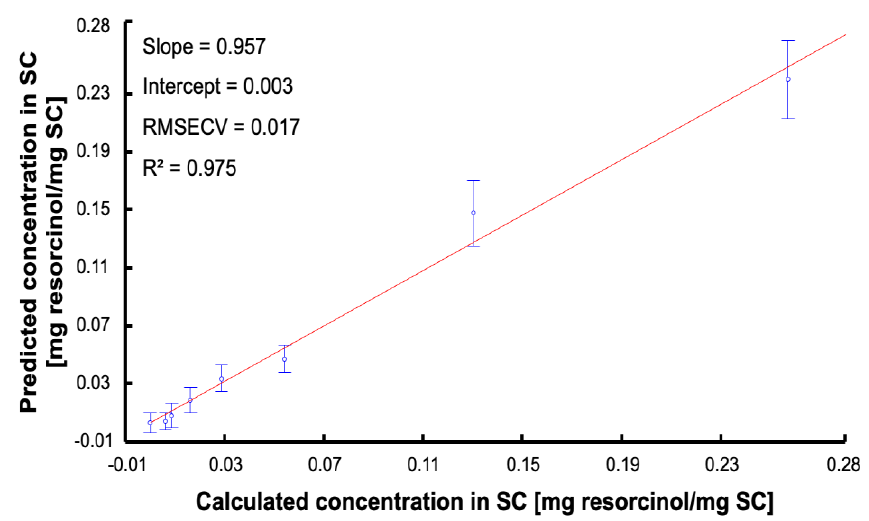
Figure 9. PLSR plot for the validation set. Dots are mean predicted concentration and errors bar represent the standard deviation.